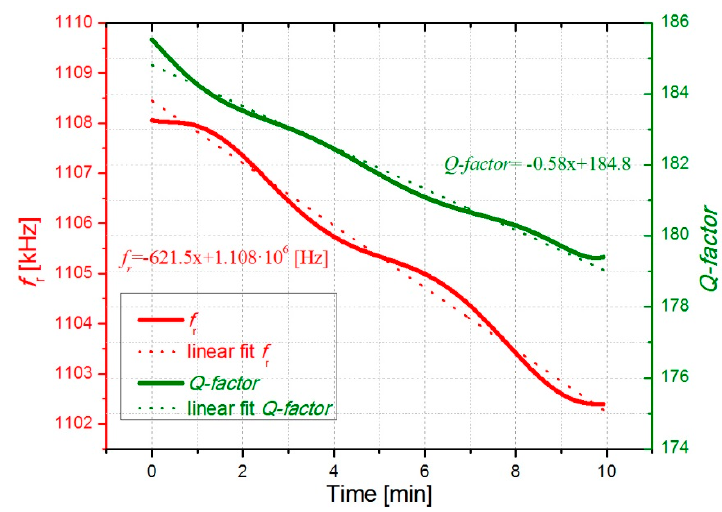
Figure 9. Closed loop measurement showing the evolution of the resonant parameters with the deposition of particles from one cigarette.